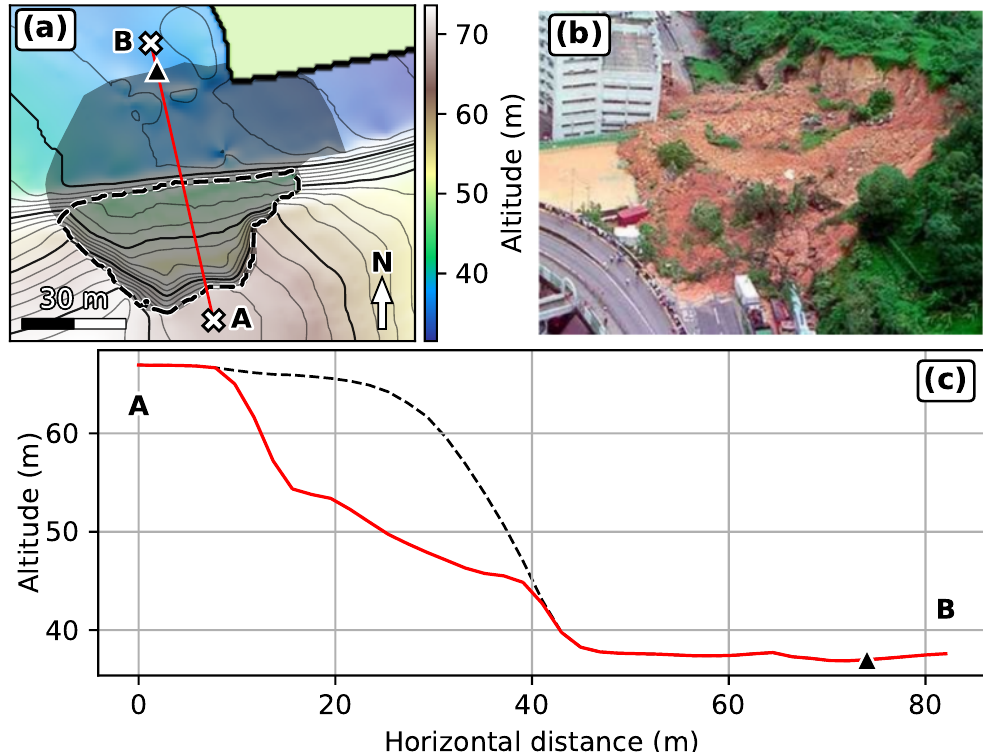
Figure 4. Fei Tsui Road debris slide. ( a ) Post collapse topography with deposits removed, 1 m DEM. Black dashed outline: landslide scar. Dark area: observed landslide extent. Bold contour interval is 10 m. Red line: cross-section along which travel distances are measured. Dark triangle: Observed travel distance. ( b ) Picture of Fei Tsui Road debris slide (GEO, Hong-Kong). ( c ) Cross-section along red line in ( a ). Red line: Post-collapse topography. Black dashed line: Reconstructed pre-collapse topography with deposits removed. Black triangle: observed deposit